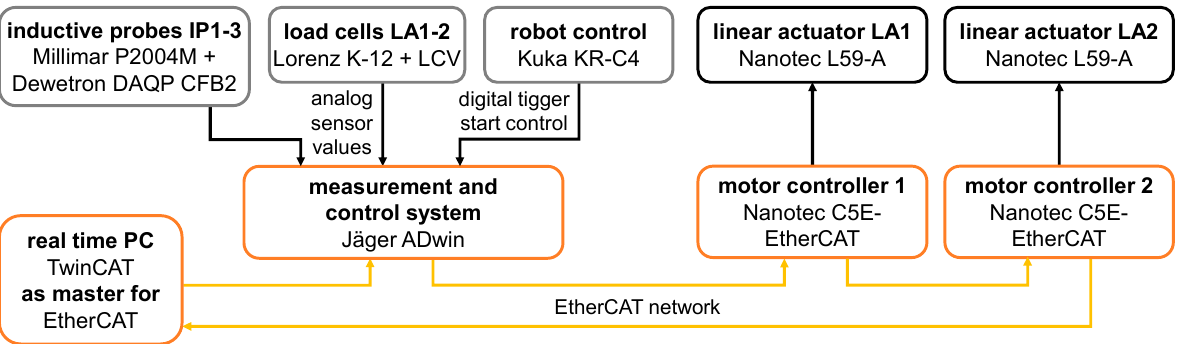
Figure 5. Schematic figure of the bus system for sensor and actuator integration. This procedure enabled the integration of the analog sensor signals from inductive probes IP1-3 and load cells LC1-2 and a digital signal from the robot control regarding start/stop of the closed-loop control. The conversion of analog values into digital values was done with a 16-bit multiplexer and an operating range of ± 10 V was addressed for sensor signals. The signals were transferred to the bus system at a frequency of 1000 Hz. It should be noted that the load cell signals were preprocessed in advance to reduce noise by applying a moving average over 50 data points within the ADwin program.